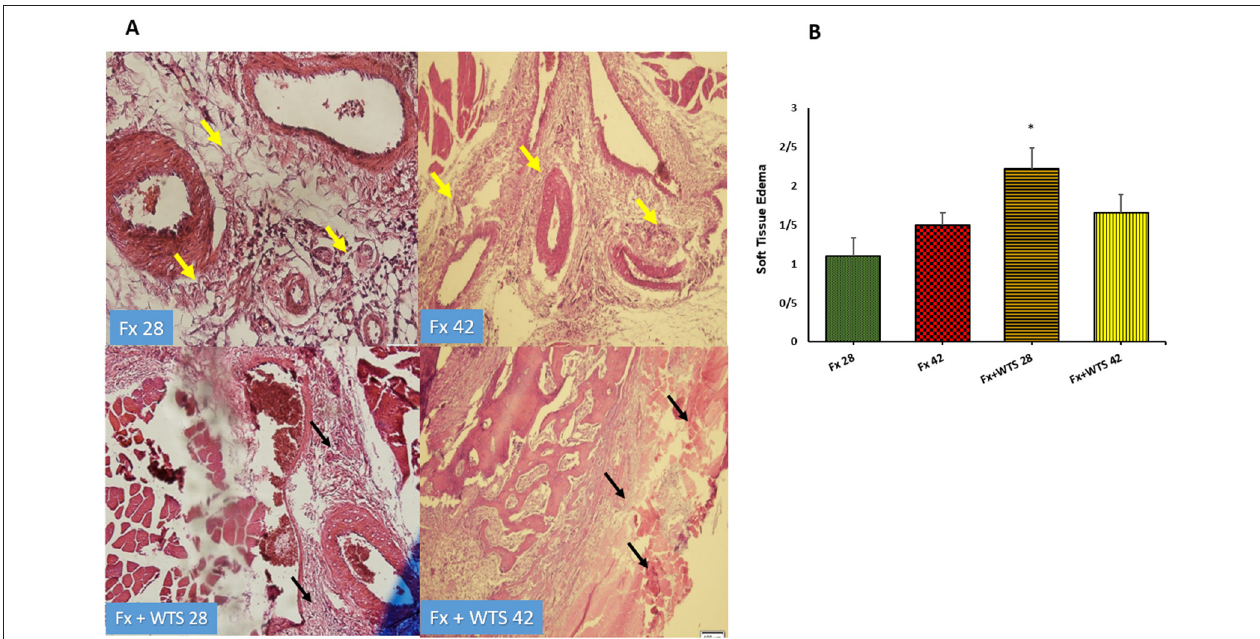
FIGURE 7 | (A) Pathological representation of soft tissue edema. In the Fx 28 group, edema has decreased and indicates regular soft tissue without edema (the yellow arrows). In Fx 42 group, the same is true. In Fx + WTS 28 group, the soft tissue around the fracture is completely edematous and irregular and the beginning of the fibrosis process is observed (black arrows). In Fx + WTS 42 group, the surrounding tissue is completely fibrotic and edematous (black arrows). (B) The quantification of the soft tissue edema finding in experimental groups. Fx 28: group subjected to room air for 28 days after surgery and a femoral bone fracture, Fx 42: group subjected to room air for 42 days after surgery and a femoral bone fracture, Fx + WTS 28: group subjected to WTS for 28 days after surgery and a femoral bone fracture, Fx + WTS 42: group subjected to WTS for 42 days after surgery and a femoral bone fracture. The results are presented as mean ± SEM, n = 10. * P < 0.05 vs. Fx